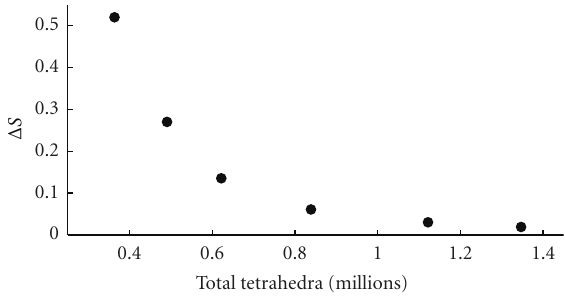
Figure 7: HFSS convergence with number of tetrahedra for each adaptive meshing